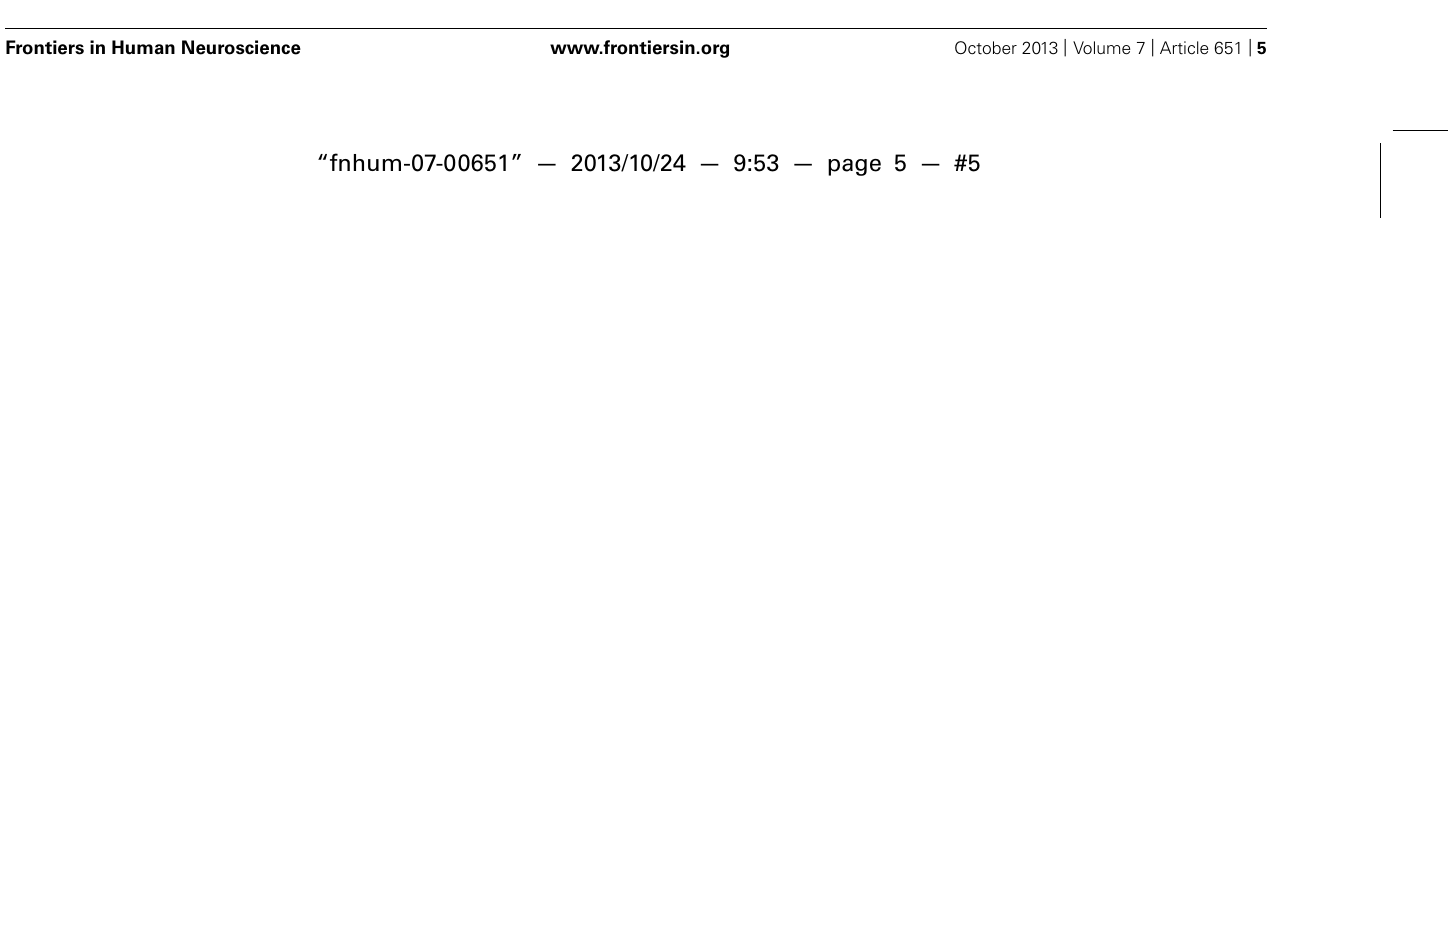
FIGURE 3 | (A) Mean reaction times (lines) and error rates (bars) for the congruent, neutral and incongruent conditions of the flanker task for glucose (solid lines; gray bars) and placebo (dashed lines, white bars) in experiment 1. (B) Session effects in the task, session 1 – placebo, session 2 – glucose. Mean reaction times (lines) and error rates (bars) for glucose (solid lines; gray